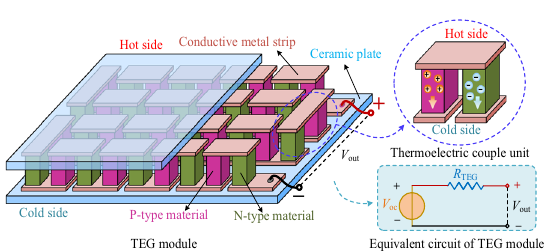
Fig. 1 Schematic of TEG and equivalent circuit of TEG module